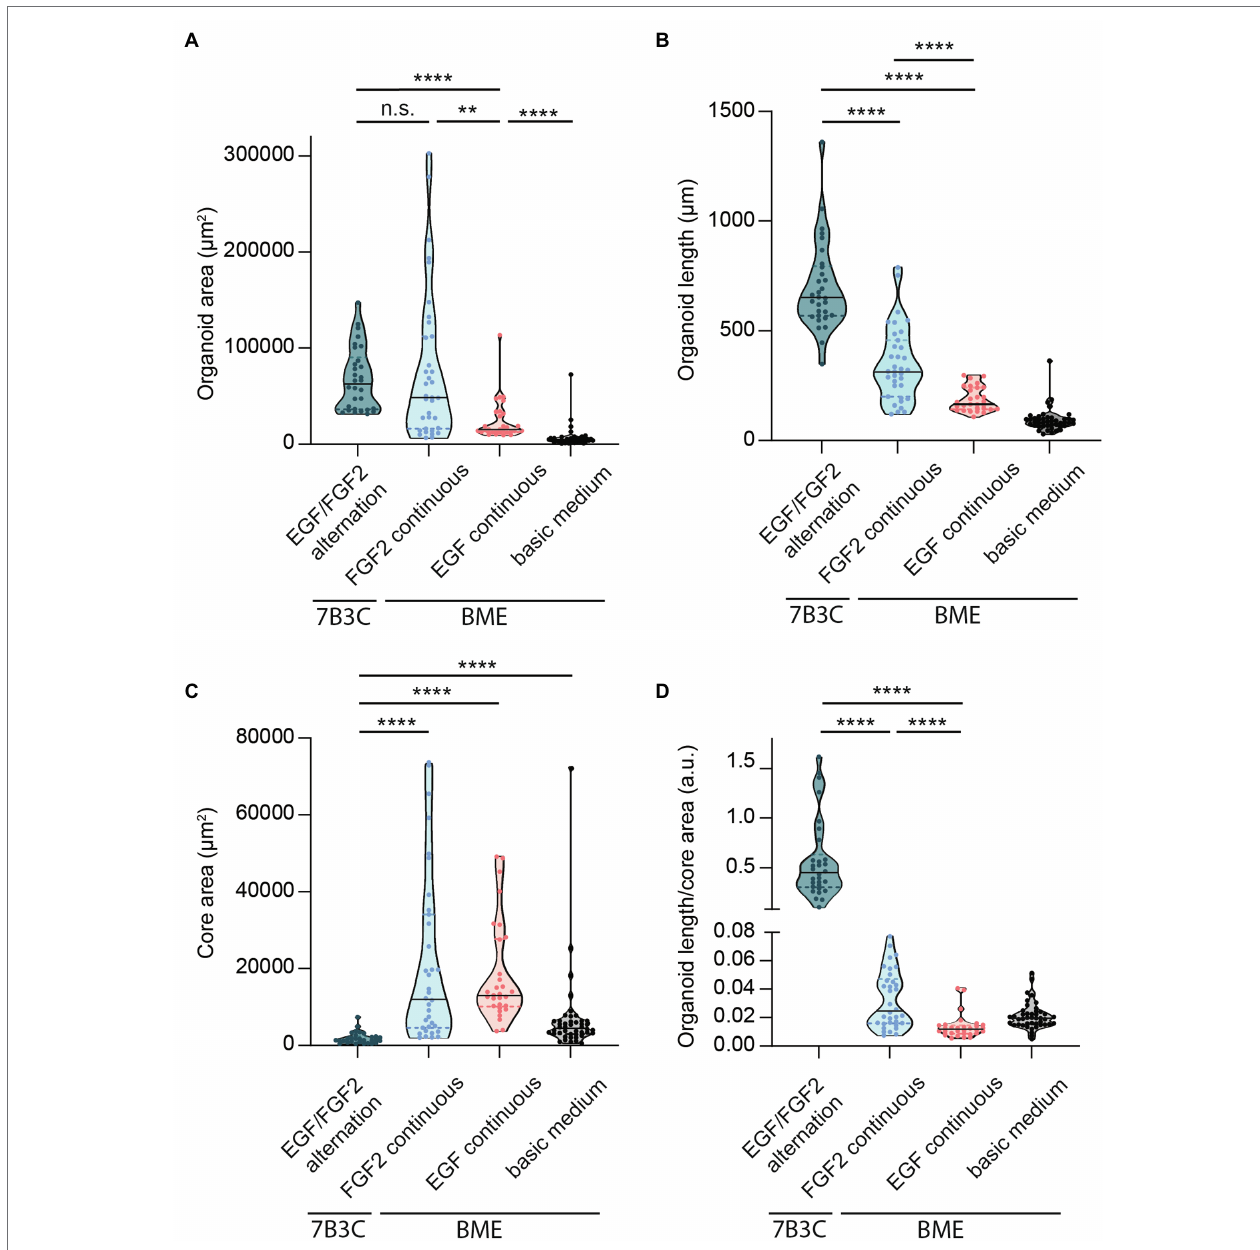
FIGURE 5 | Quantification of mammary organoid size and morphology under different culture conditions. Quantification of mammary organoid area (A) , organoid length (B) , and organoid core size (C) . (D) Organoid length/core area was determined as a robust parameter to accurately describe the difference between complex branched organoids and hyperbranched or budding organoids. All parameters were quantified at day 18 of culture for all conditions; data represent >30 organoids per condition derived from three experimental replicates. Significance was tested using a Mann–Whitney test, ** p ≤ 0.01, and **** p ≤